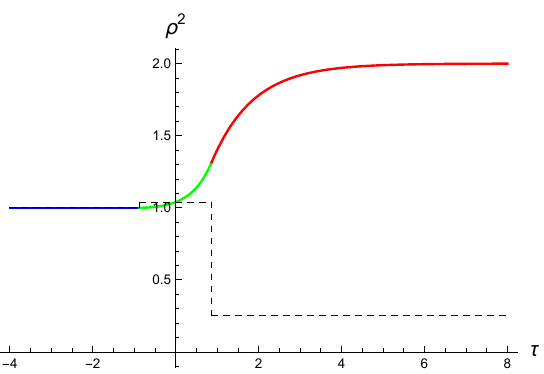
Figure 5. (cid:26) ( (cid:28) ) 2 for a (cid:12)ne-tuned pulse quench with ! 0 = 1 ; ! 2 = 51 = 50 ; ! 1 = 1 = 2. The blue part of the curve corresponds to (cid:28) < (cid:0) T= 2, the green part for (cid:0) T= 2 < (cid:28) < T= 2 and the red part is (cid:28) > T= 2. The quench pro(cid:12)le is shown by dashed lines.